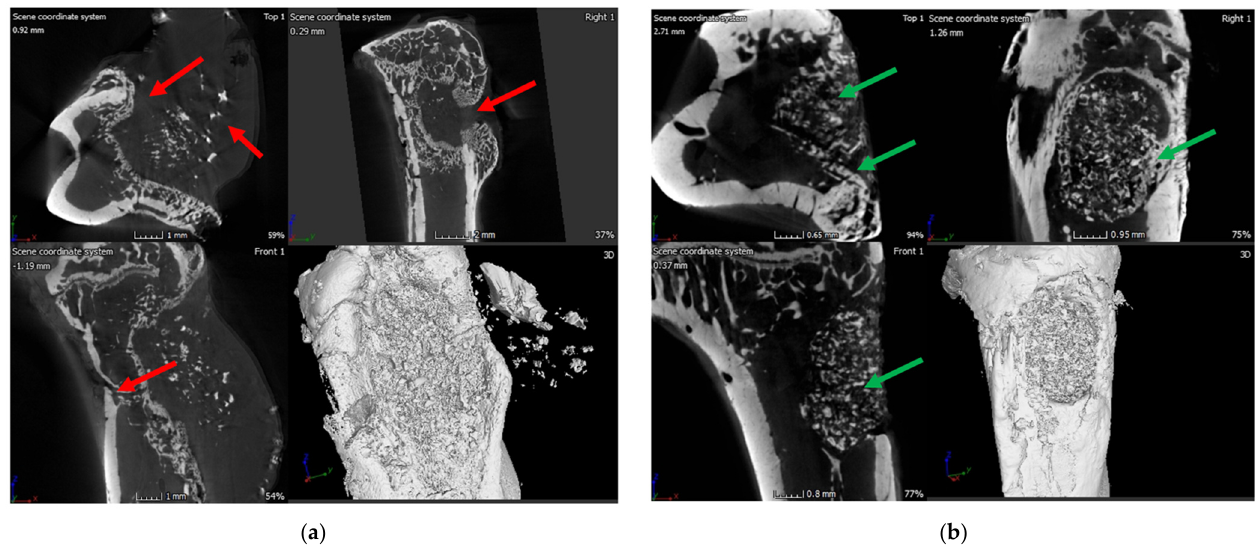
Figure 11. ( a ) µ-CT images of the rat bone in the infection control group showed signs of infection: narrowing of marrow space, presence of puss-filled fibrous capsule, sinus tract, and deformed bone with ectopic bone growth (red arrows); ( b ) The treatment group rat bone µ-CT images is showing signs of healing bone as well as the formation of cortical and cancellous bone in the space where the hole was drilled (green arrows).